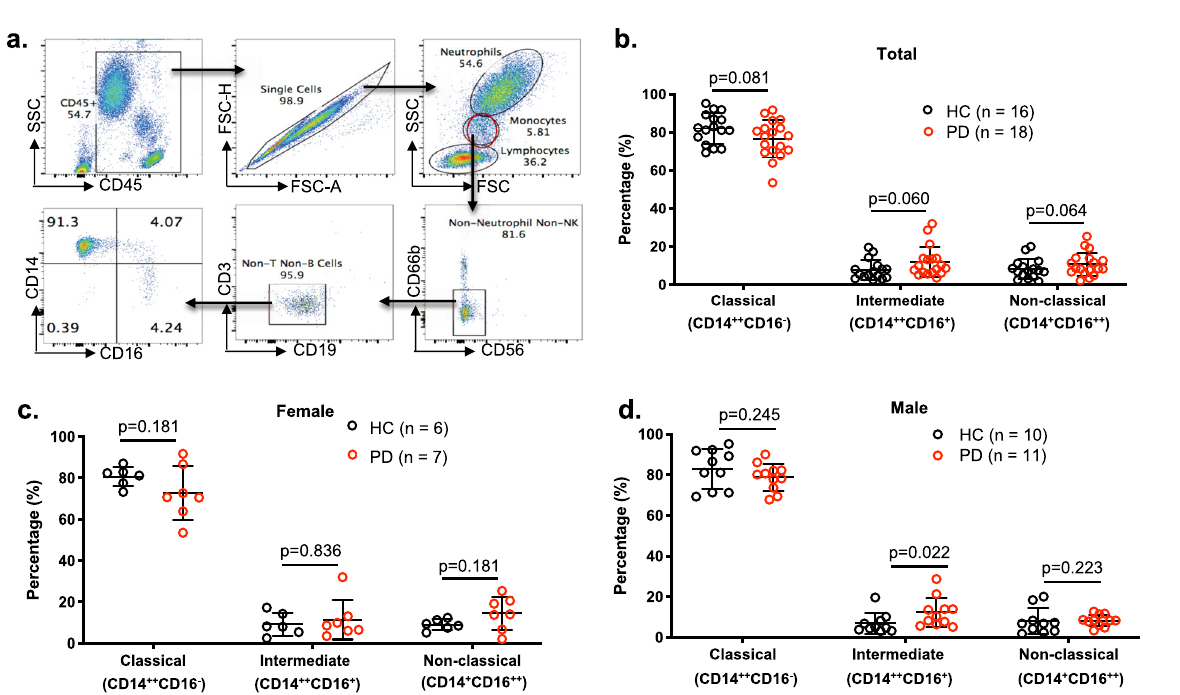
Fig. 1 Gating strategy for monocyte subsets and the analysis of monocyte subsets in PD patients and healthy controls. a Single CD45 + white blood cells (WBCs) were gated as lymphocytes, monocytes, and neutrophils. The monocyte populations were further gated as CD56 − CD66b − CD3 − CD19 − cells, and then monocyte population was classi fi ed as Classical (CD14 ++ CD16 − ); Intermediate (CD14 ++ CD16 + ); and Non-classical (CD14 + CD16 ++ ) monocyte subsets. Classical, Intermediate, and Non-classical monocytes from Parkinson disease (PD) and healthy control (HC) subjects were analyzed in total ( b ), female ( c ), and male ( d ) subjects. Statistical analysis was done using Student ’ s